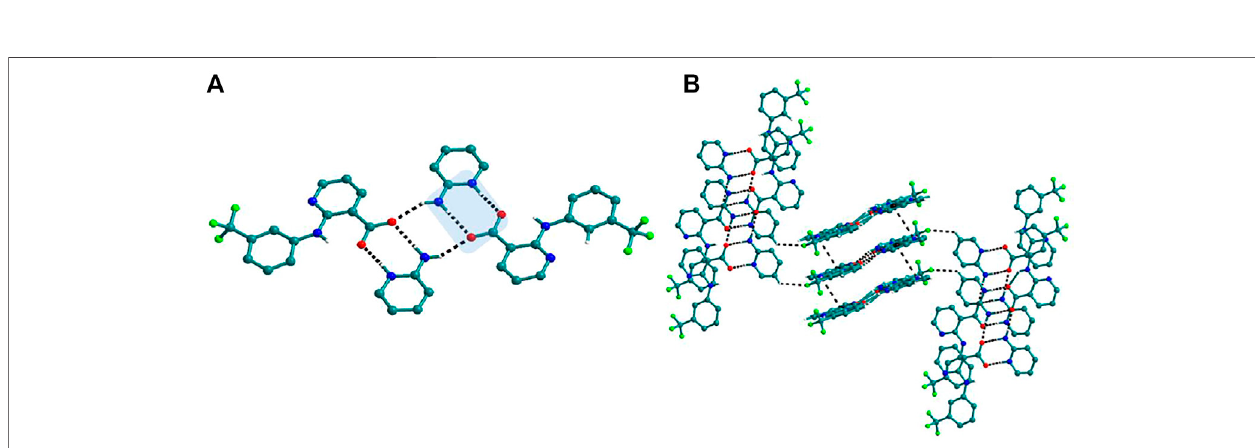
FIGURE 7 |(A) Interaction of Nif ─ 2ap dimers via N ─ H ··· O with other dimers to form a tetramer, in 4a . (B) Stackingof tetramer through C − H ··· π interaction one over the other and cross-sects each other via C − H ··· F interaction to form a 3D structure.